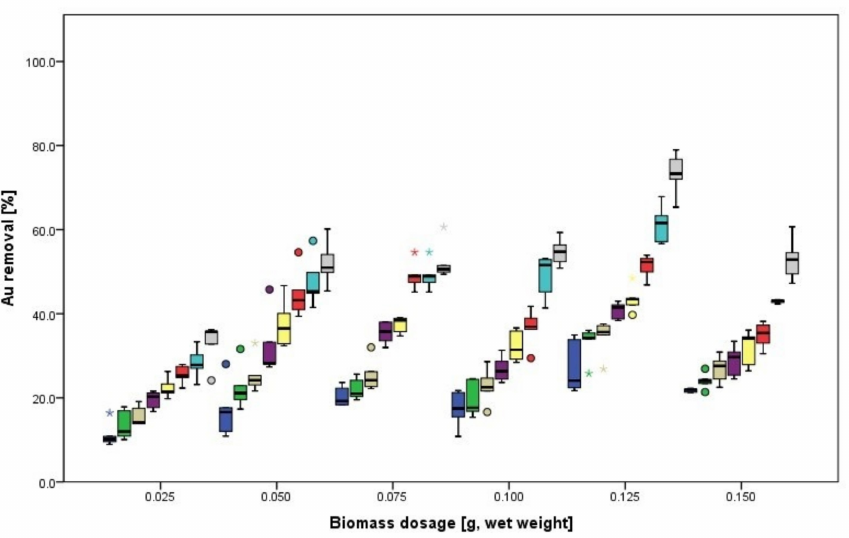
Figure 12. Au removal by different quantities (wet weight) of Aspergillus tabacinus pellets and at different contact times. (cid:4) : 1 h; (cid:4) : 2 h; (cid:4) : 3 h; (cid:4) : 4 h; (cid:4) : 5 h; (cid:4) : 6 h; (cid:4) : 12 h; (cid:4) : 24